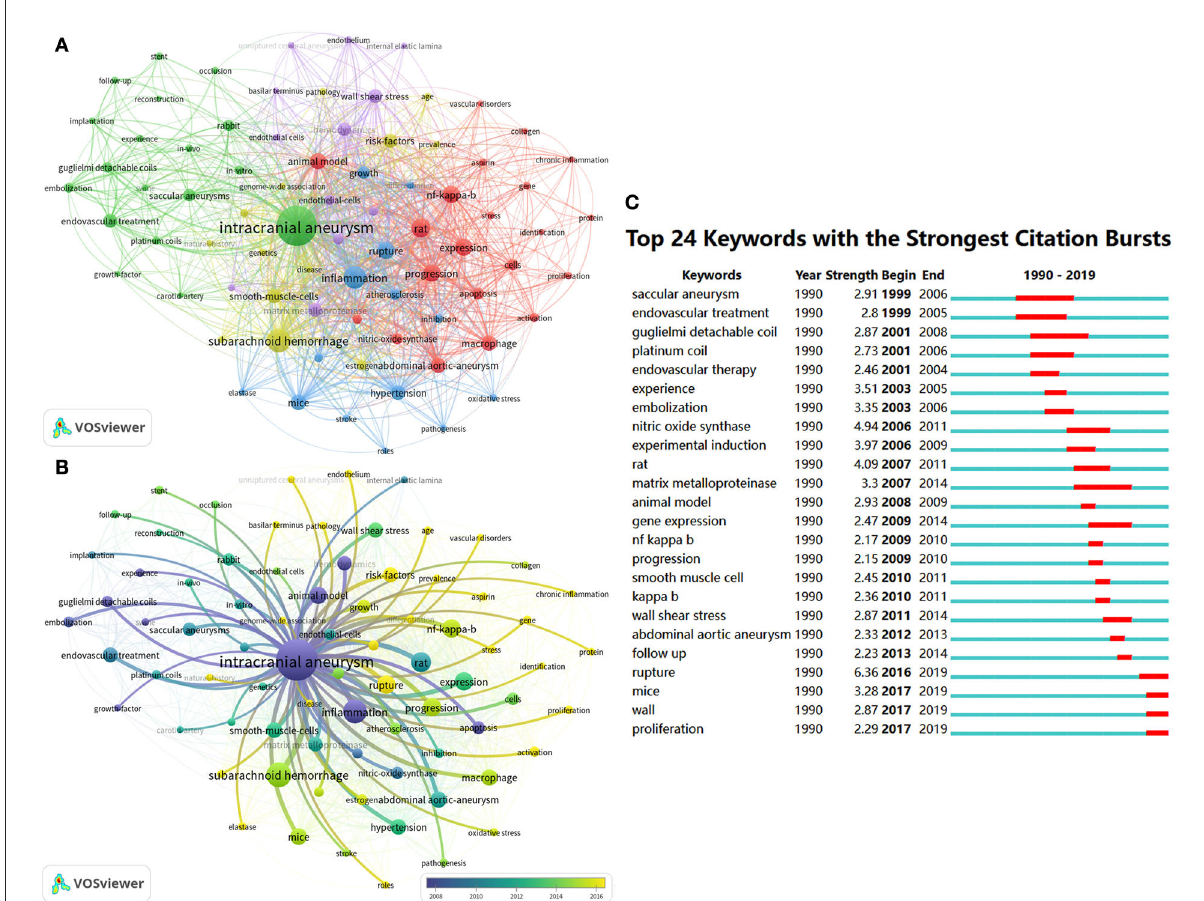
FIGURE5 Keyword co-occurrence analysis related to IA anmial studies. The keyword co-occurrence network of animal IA studies (A,B) . Keywords clustered into five groups according to their color. “Rat-related IA research (cluster#red),” “endovascular treatment-related IA research (cluster#green),” “mice-related IA research (cluster#yellow),” “hemodynamics-related IA research (cluster#purple),” and “others (cluster#blue).” Large nodes represent keywords with high frequency; 24 keywords with the strongest citation bursts from 1990 to 2021 in CiteSpace are displayed. The red segment on the blue line indicates the burst duration (C)